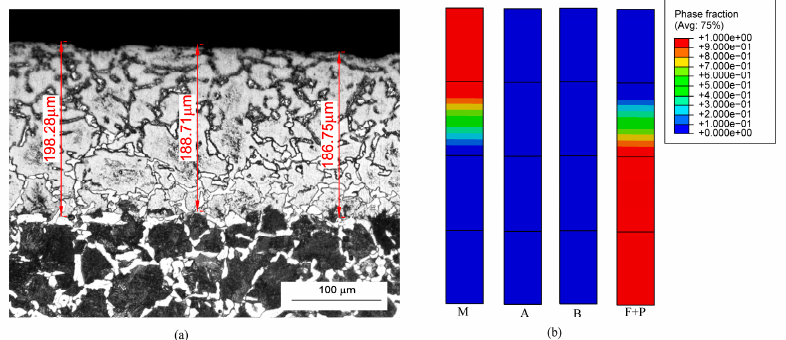
Figure 5. Microstructure distribution of the strengthened layer under no. 2 grinding parameter: ( a ) experimental result; ( b ) simulated result.